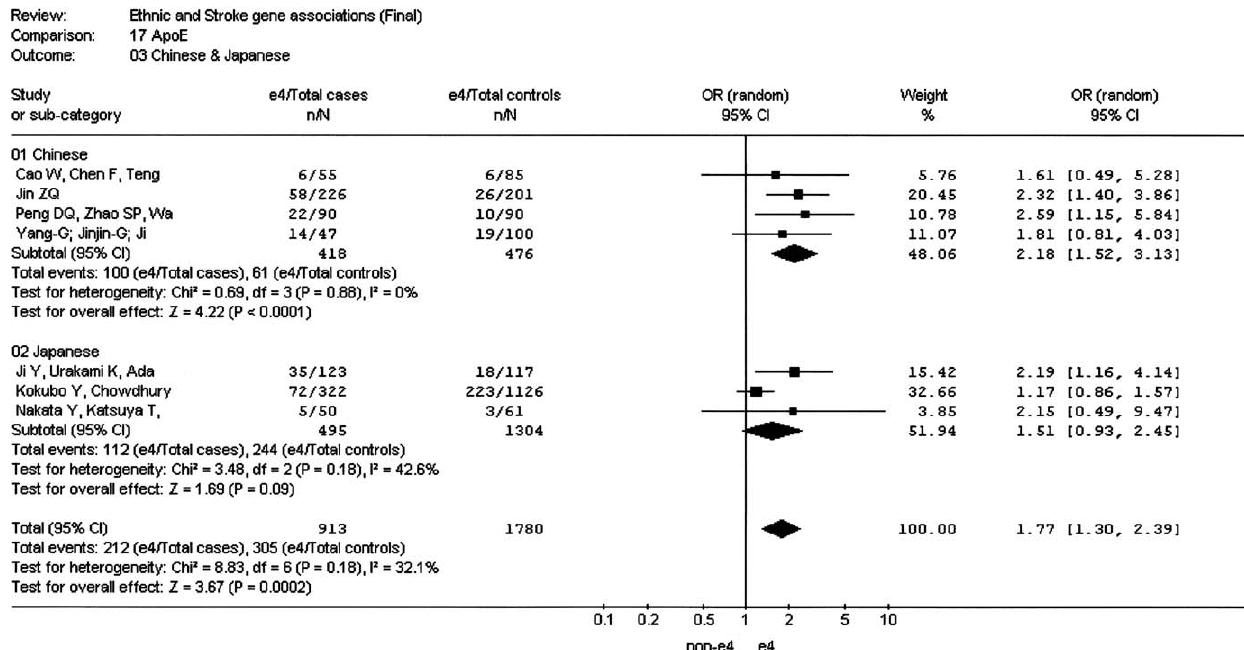
Figure 3. Meta-Analysis of Studies of the APOE e 2/ e 3/ e 4 Polymorphism and Risk of Stroke in Chinese and Japanese